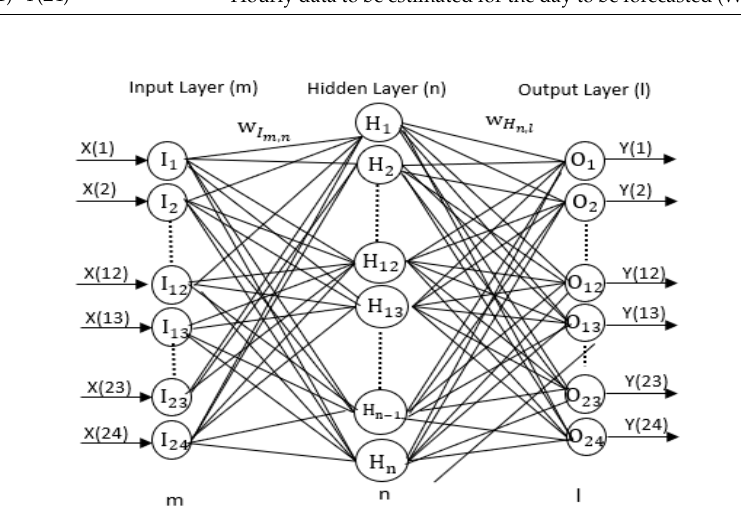
Figure 4. The structure of the designed artificial neural network (ANN). Table 4. Input and output variables of ANN.